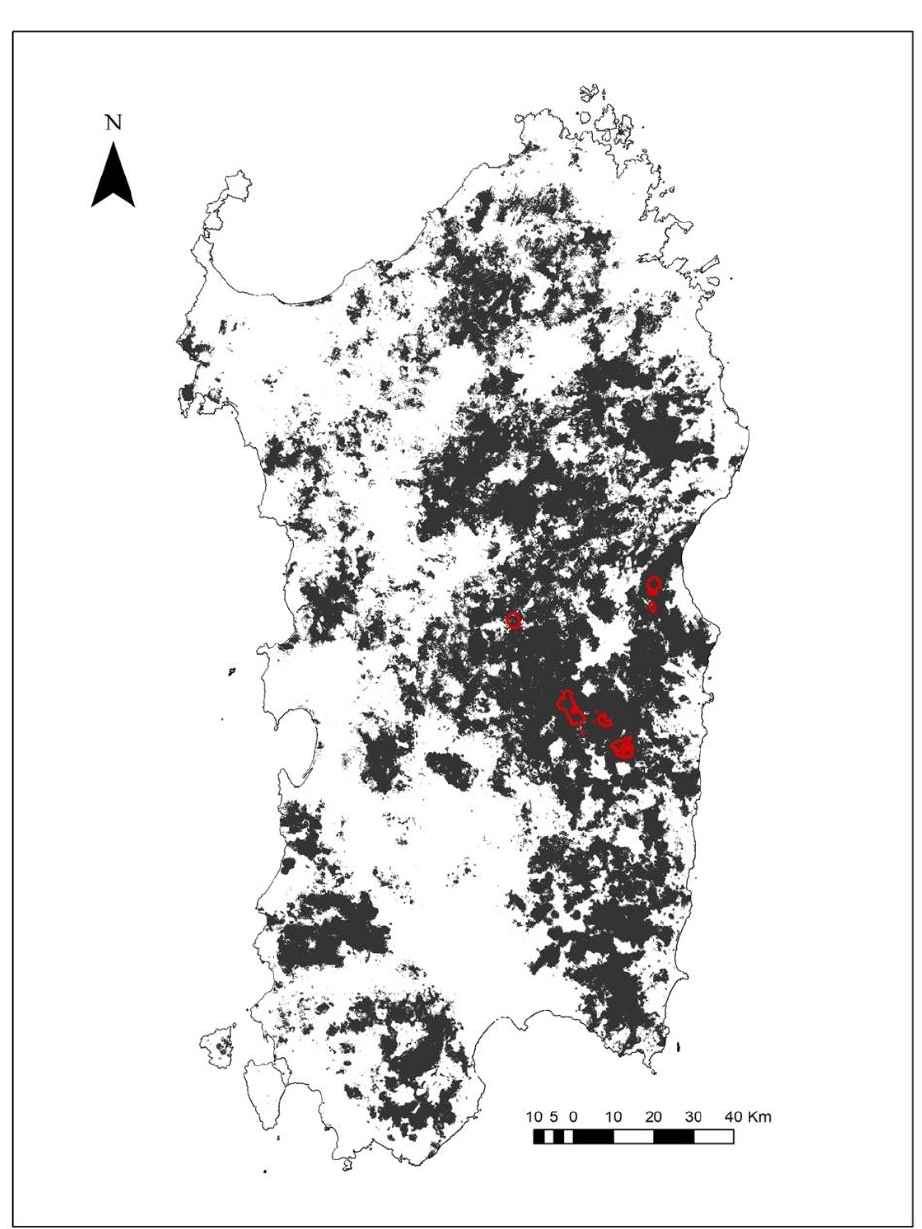
Figure 3. Binary species distribution model for the reintroduced Corsican red deer (the suitable areas are in black and the merged core areas are in red of tracked deer). Table 4. Relative contributions of the environmental variables to the MaxEnt